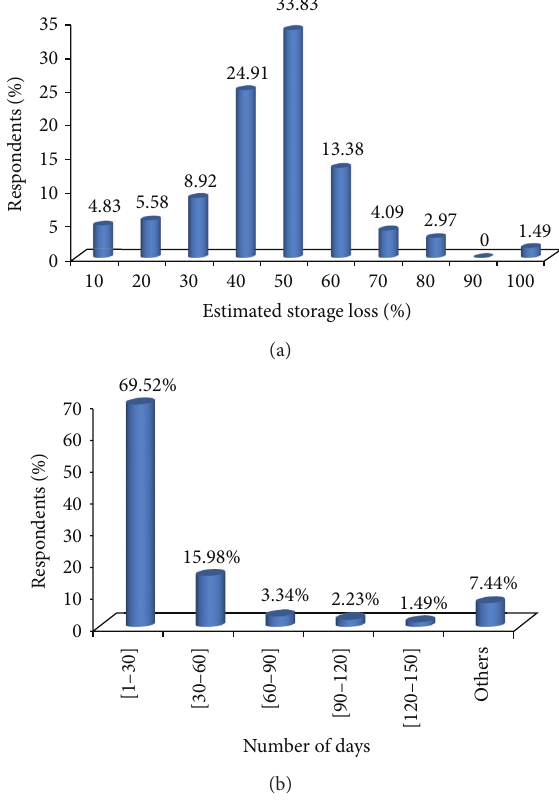
Table 3: Solutions for the constraints and their importance as proposed by the interviewees in the study